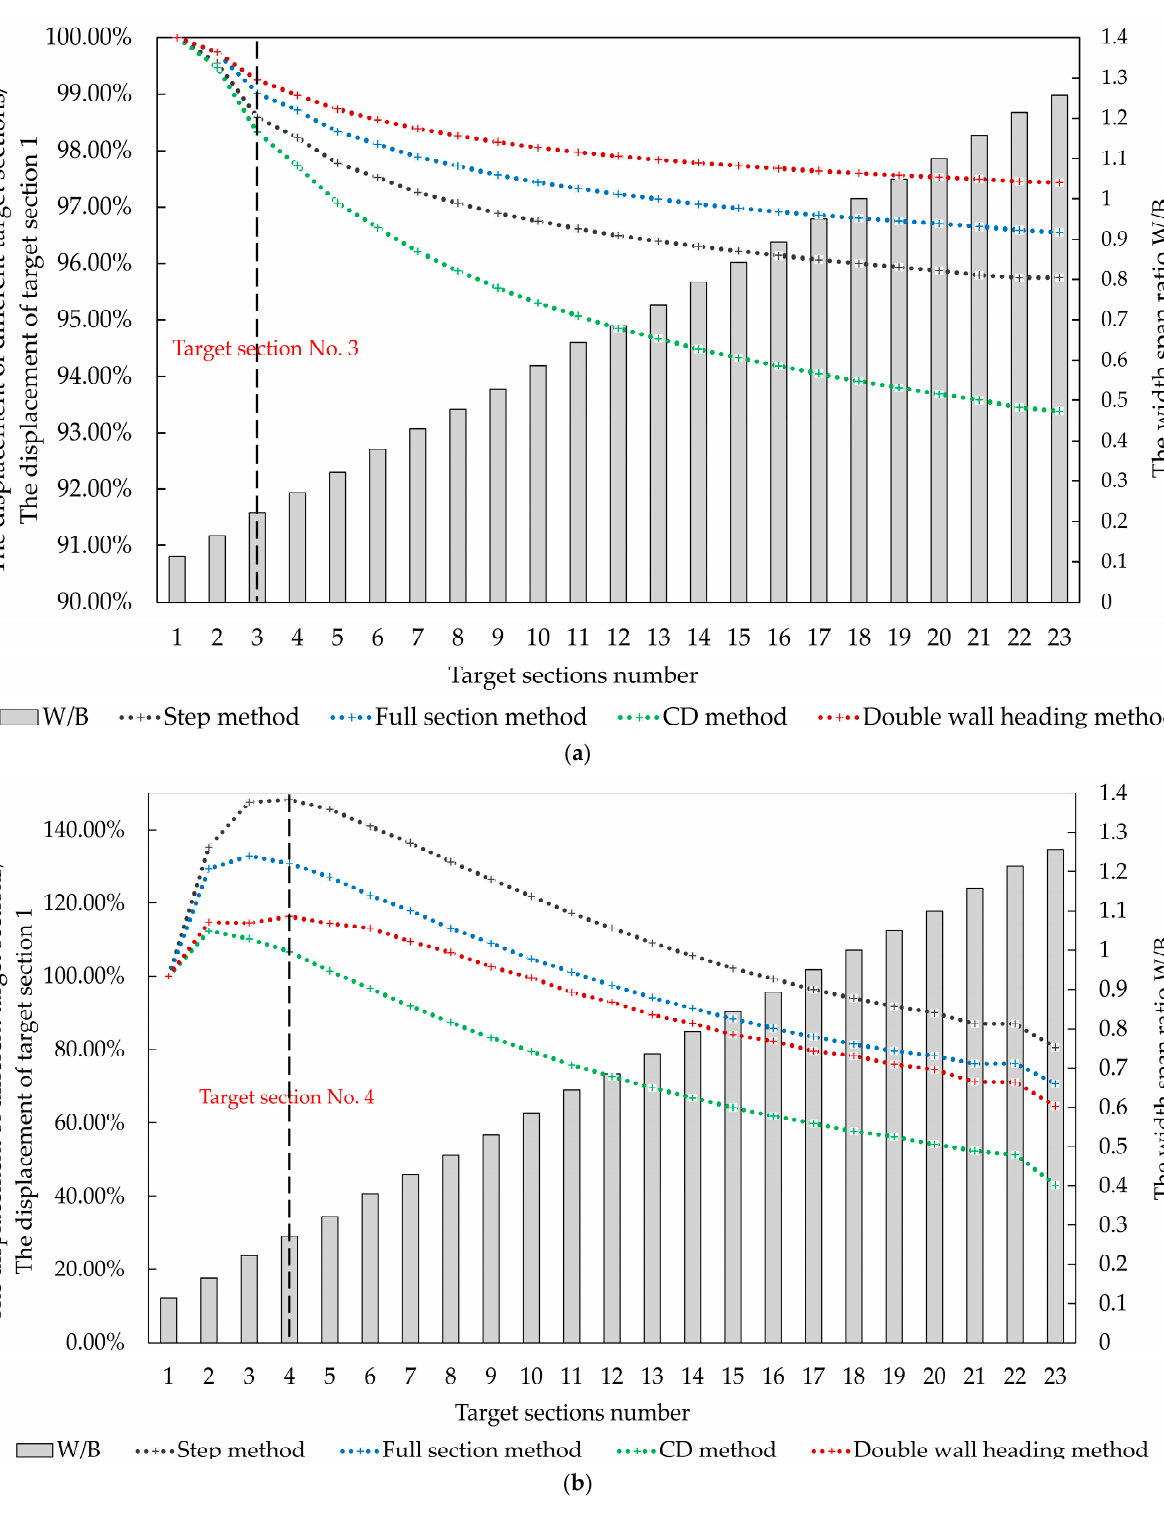
Figure 6. Relationship between the displacement and the width–span ratio of the central area of the middle rock pillar: ( a ) vertical displacement; ( b ) horizontal displacement.